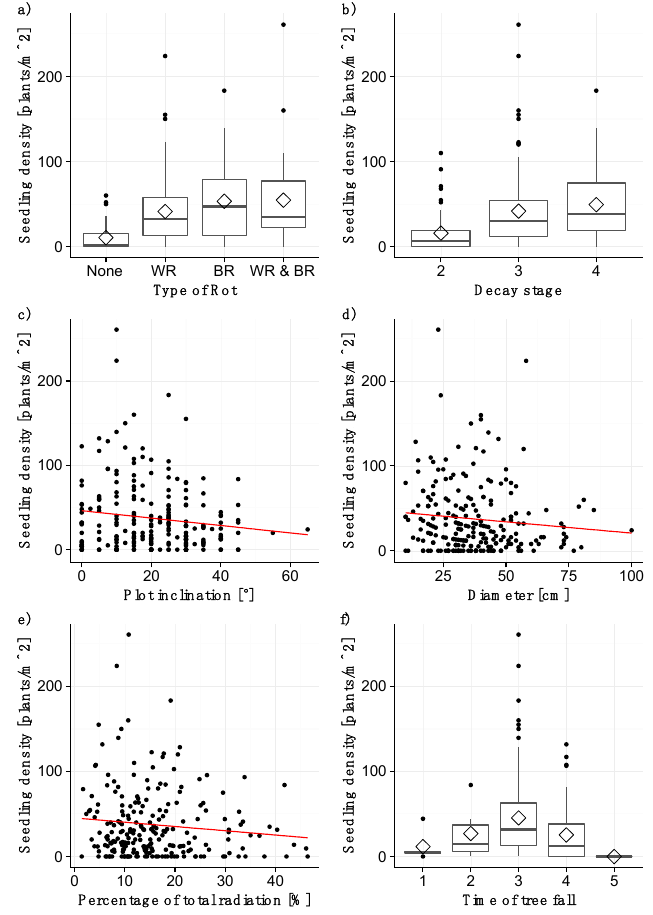
Figure 1. Significant variables for the seedling model: ( a ) type of rot (WR = white rot, BR = brown rot), ( b ) decay stage, ( c ) plot inclination, ( d ) diameter, ( e ) percentage of total radiation, and ( f ) time of tree fall (1 = before 1965, 2 = 1965–1977, 3= 1977–1989, 4 = 1989–2006, 5 = after 2006). The straight line represents the model fit, the grey shaded area the confidence interval. The rhombuses in ( a , b , f ) indicate the mean seedling density.